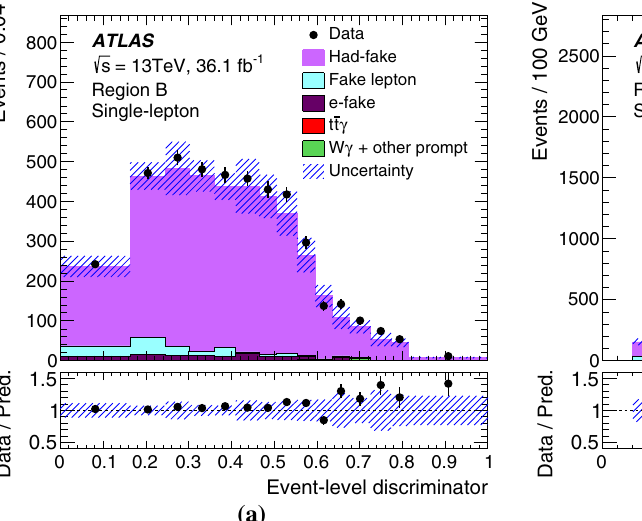
The contributions from t ¯ t γ and W γ + other prompts are very small (0.2% and 0.3%, respectively), therefore not visible